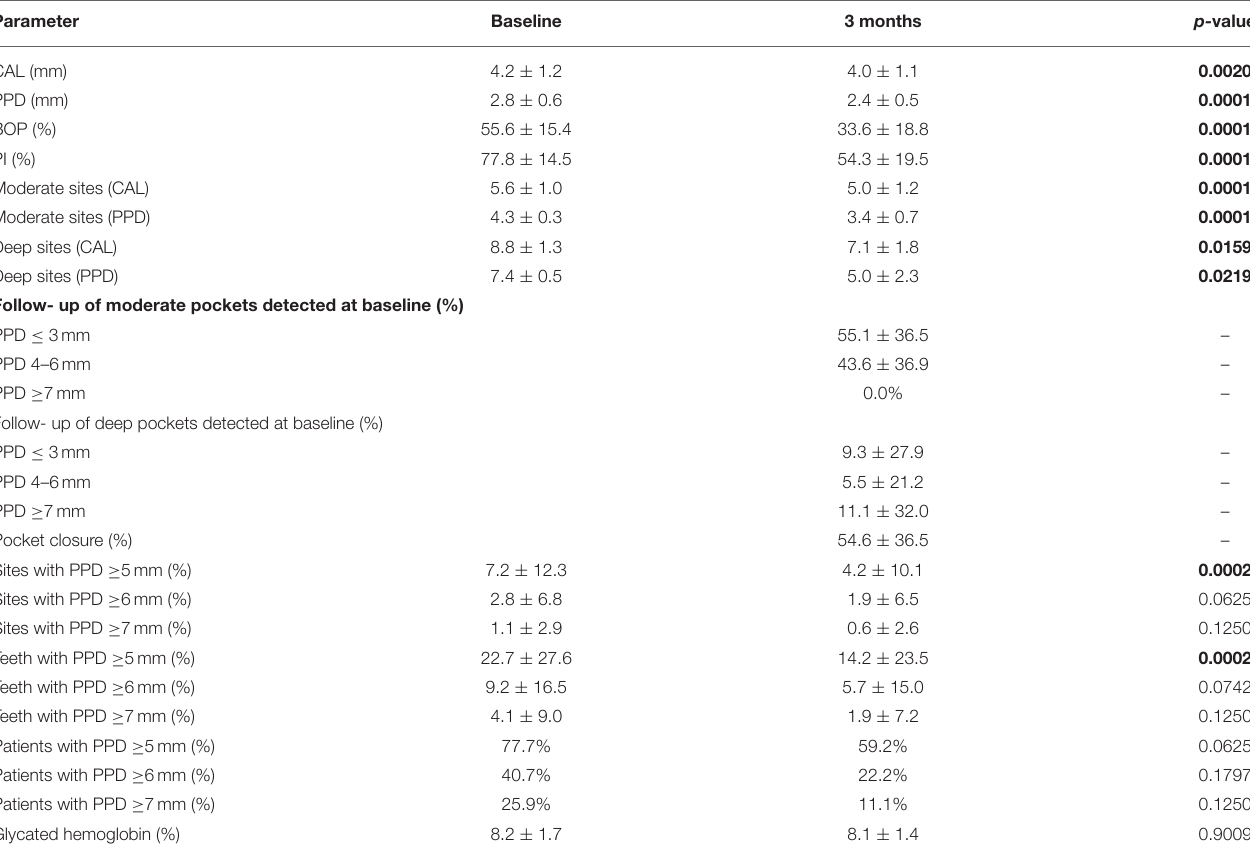
TABLE 4 | Clinical parameters and glycated hemoglobin at baseline and 3 months follow-up in treated group ( n = 27), prior pandemic. Parameter